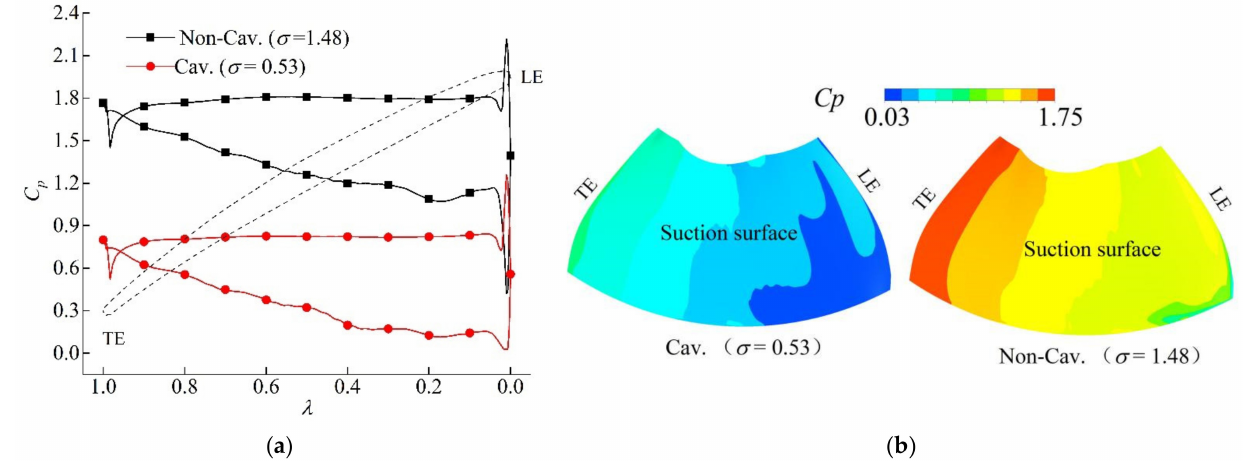
Figure 7. Pressure coefficient distribution of blade surface. ( a ) Curves of the pressure coefficient; ( b ) Pressure coefficient distribution on the suction